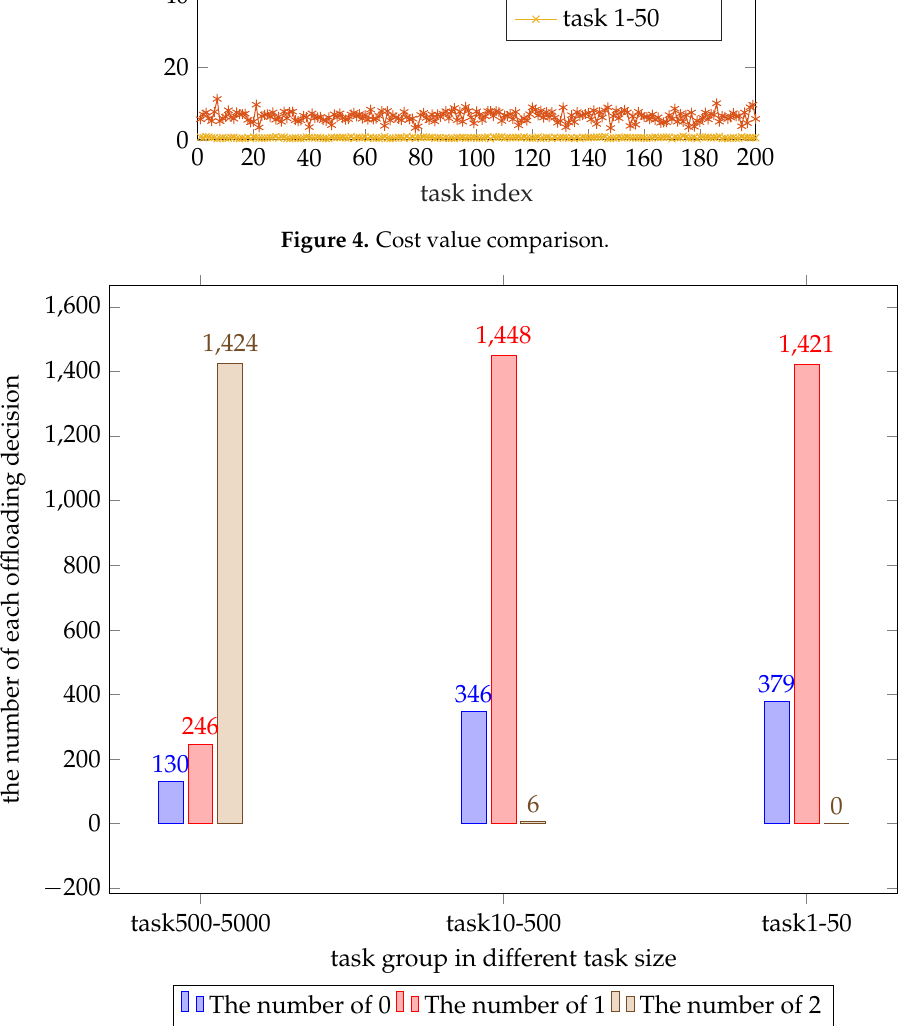
Figure 5. The number of each decision for each set of